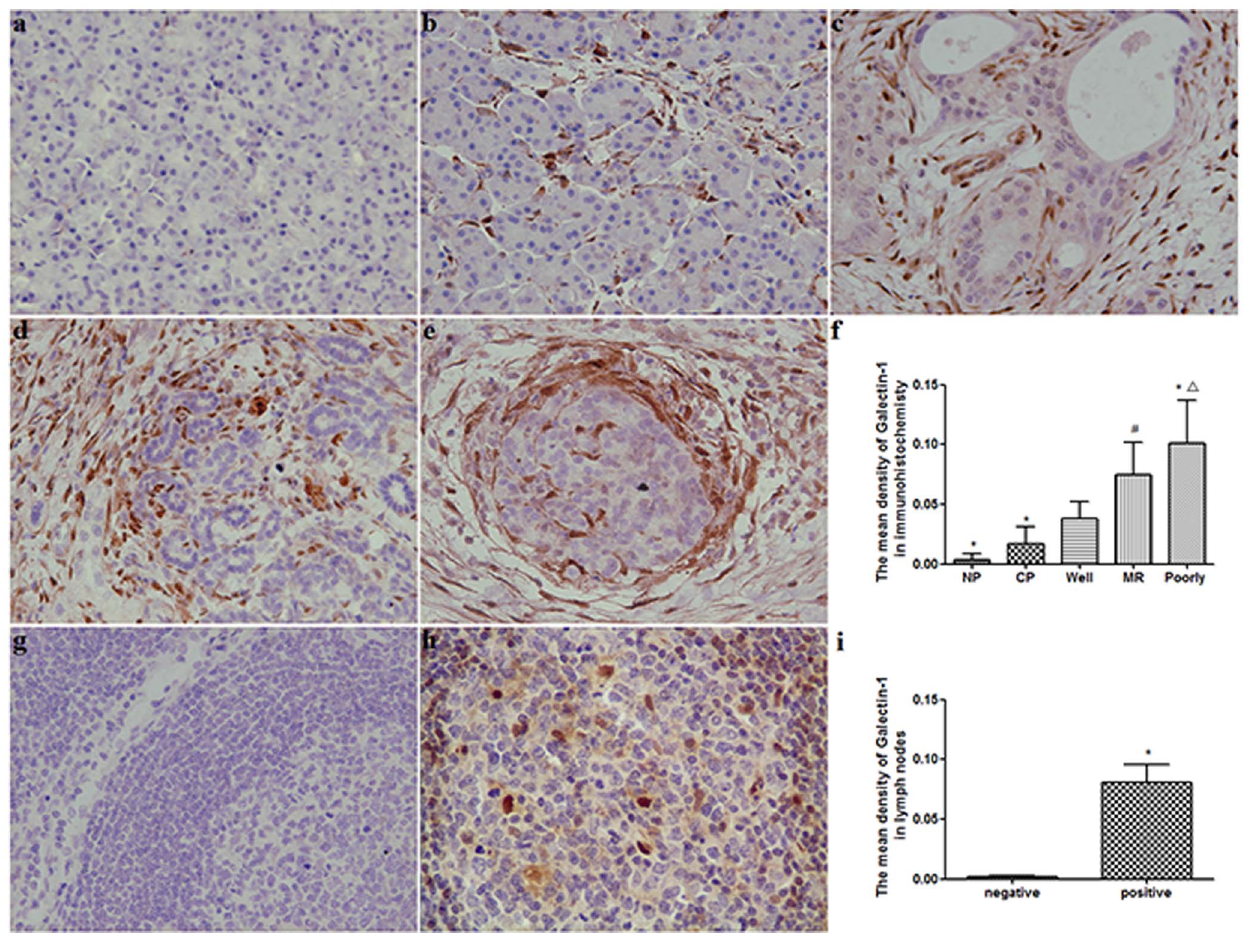
Figure 1. Characterization of Galectin-1 expressed in pancreatic disease. ( a ) Negative Galectin-1 expression in normal pancreas tissue. ( b ) Weak Galectin-1 expression in the stromal of chronic pancreatitis tissue. ( c–e ) Strong Galectin-1 expression in stromal cells of pancreatic cancer tissue, and increased from well ( c ), moderately ( d ) to poorly ( e ) differentiated pancreatic cancer. ( f ) Quantification of mean density of Galectin-1 expression in different pancreatic tissues. * p , 0.01 vs . well, # p , 0.05 vs . well, g p , 0.05 vs . MR. NP, normal pancreas; CP, chronic pancreatitis; Well, Well differentiated pancreatic cancer; MR, moderately differentiated pancreatic cancer; Poorly, poorly differentiated pancreatic cancer. Original magnification: 6 200. ( g ) Galectin-1 expression was negative in non-metastatic peripancreatic lymph nodes. ( h ) Galectin-1 positive staining was found in metastatic peripancreatic lymph nodes. ( i ) Quantification of mean density of Galectin-1 expression in non-metastatic and metastatic peripancreatic lymph nodes. * P , 0.01 vs .